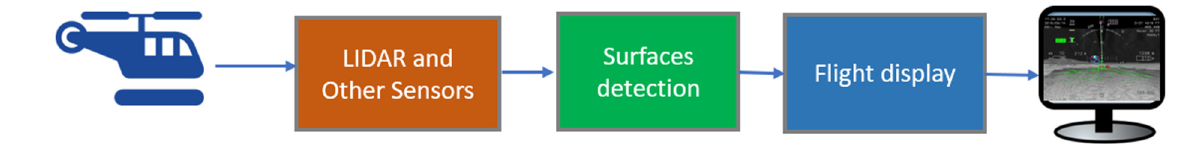
Figure 6. Depiction of Experimental setup. The algorithm parameters for all the generated results are shown in Table 4. Vega Prime software displays SLZs for the pilot in real-time. It has two windows for the same scene: the right window is the bird view, and the left window is the pilot view. In addition to that, the Vega Prime software shows SLZs in color code, where SLZs with a dark green color are certain, SLZs with a light green color are less certain, and SLZs with a red color are more uncertain. Table 4. Algorithm parameters .